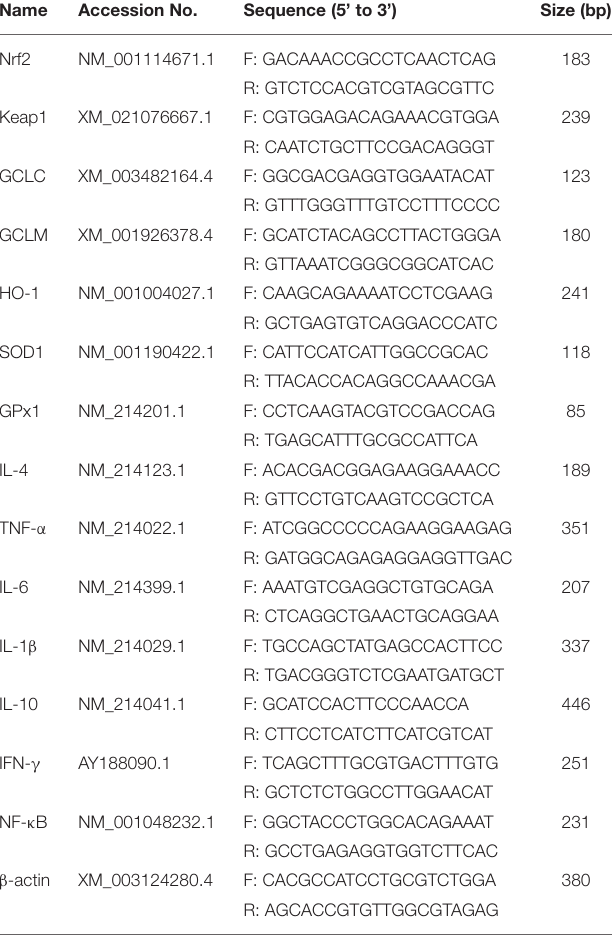
TABLE 1 | Primer sequences used in quantitative real-time PCR assays. TABLE 2 | Effects of dietary Nano-ZnO supplementation on growth performance of IUGR finishing pigs.